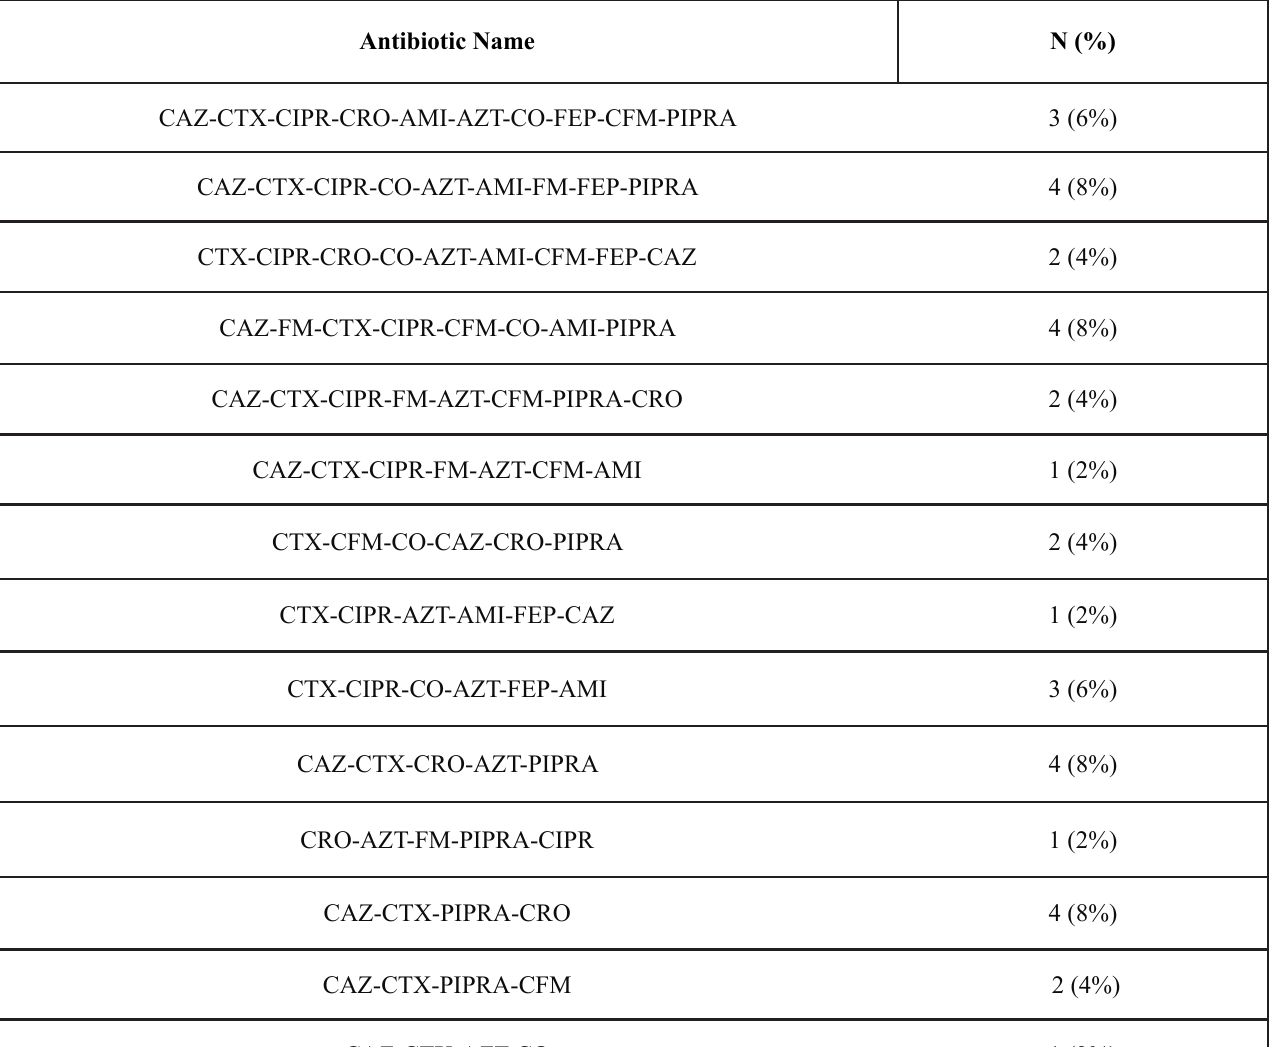
Table 3 . The distribution of MDR among isolated K . pneumoniae